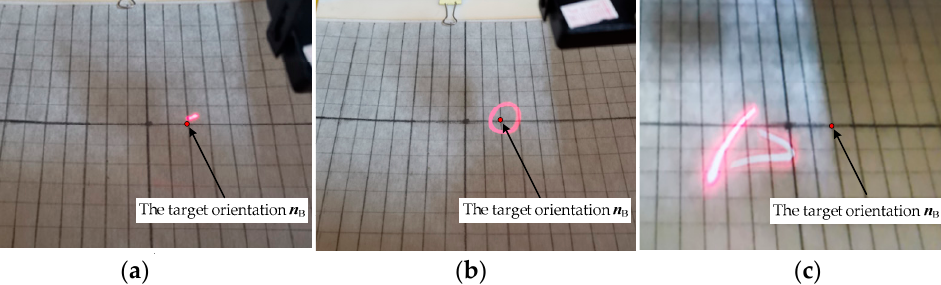
Figure 17. Snapshots of the end motion trajectories of polar axis n f . ( a ) Asymptotically stable motion; ( b ) Period motion; ( c ) Chaotic motion. Table 3. The cross experiments of the posture stability of the DSCR.